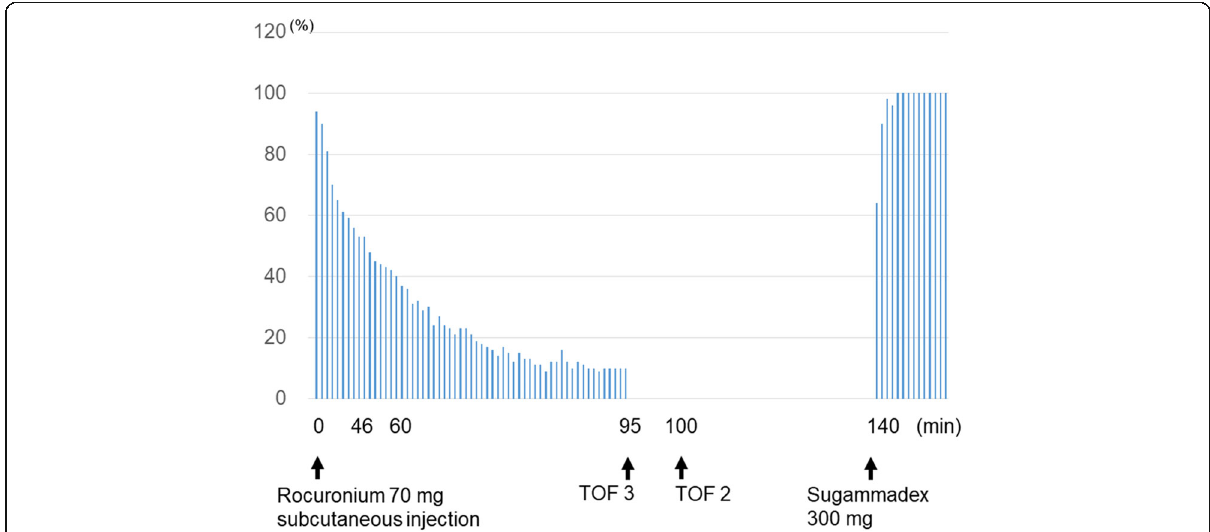
Fig. 1 Train-of-four ratio after subcutaneous administration of rocuronium. The vertical bars show progression of the TOF ratio. Slow development of the neuromuscular block was seen after subcutaneous injection of rocuronium. The fourth twitch of a train-of-four stimulation was not detected after 95 min. Train-of-four count was 3, 95 min after administration of rocuronium, and it remained 2 until the end of the surgery. Sugammadex rapidly reversed the neuromuscular block to a TOF ratio of